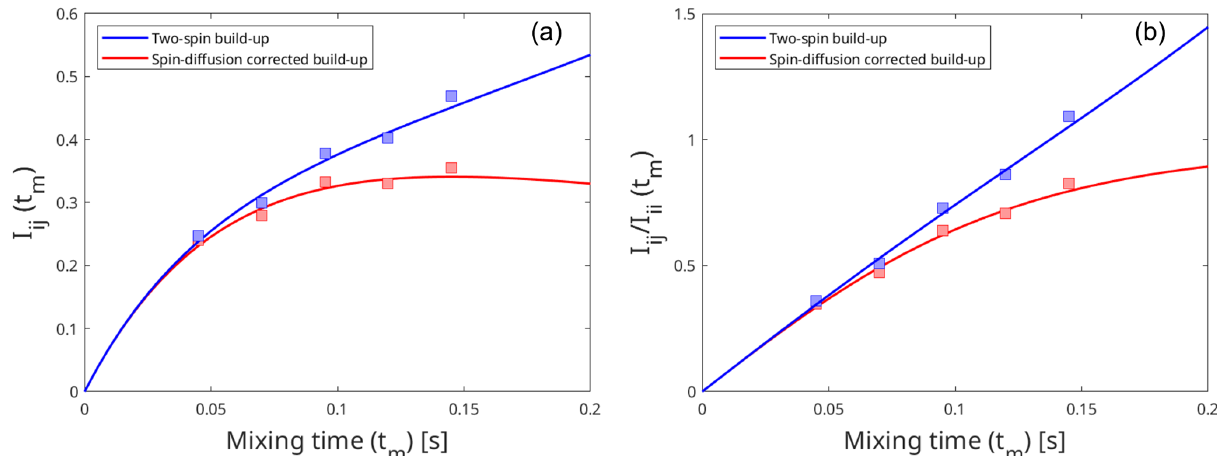
Figure A3. Effect of spin diffusion on the intensity build-up curves produced by the eNORA-based approach (a) and the diagonal-normalised approach (b) . The build-up curves were fitted using artificially simulated peak intensities in a model system, third immunoglobulin-binding domain of protein G (GB3), which has been extensively studied using eNOE spectroscopy (Vögeli et al., 2012, 2013). The blue curve represents the intensity build-up in an isolated two-spin system, with an inter-proton distance of 3.83Å, and the red curve represents the same two spins experiencing spin diffusion due to the presence of other spins in the system. The comparison between the plots highlight that it is easier to detect the influence of spin diffusion with the diagonal-normalised approach (b) , as it induces deviation from the expected linear